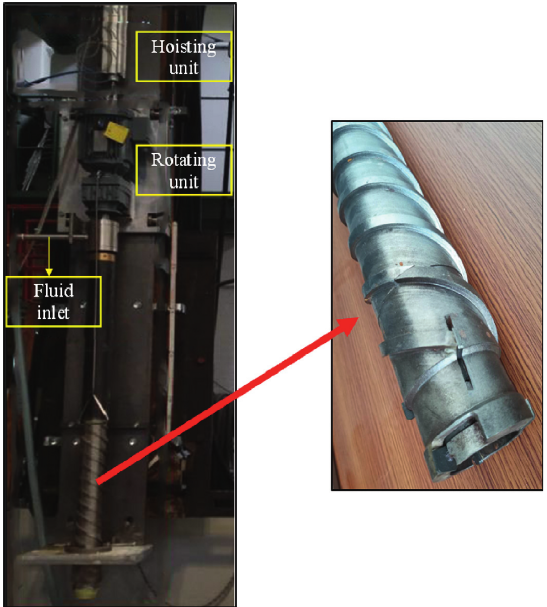
Figure 8: Experimental equipment and coring bit assembly.